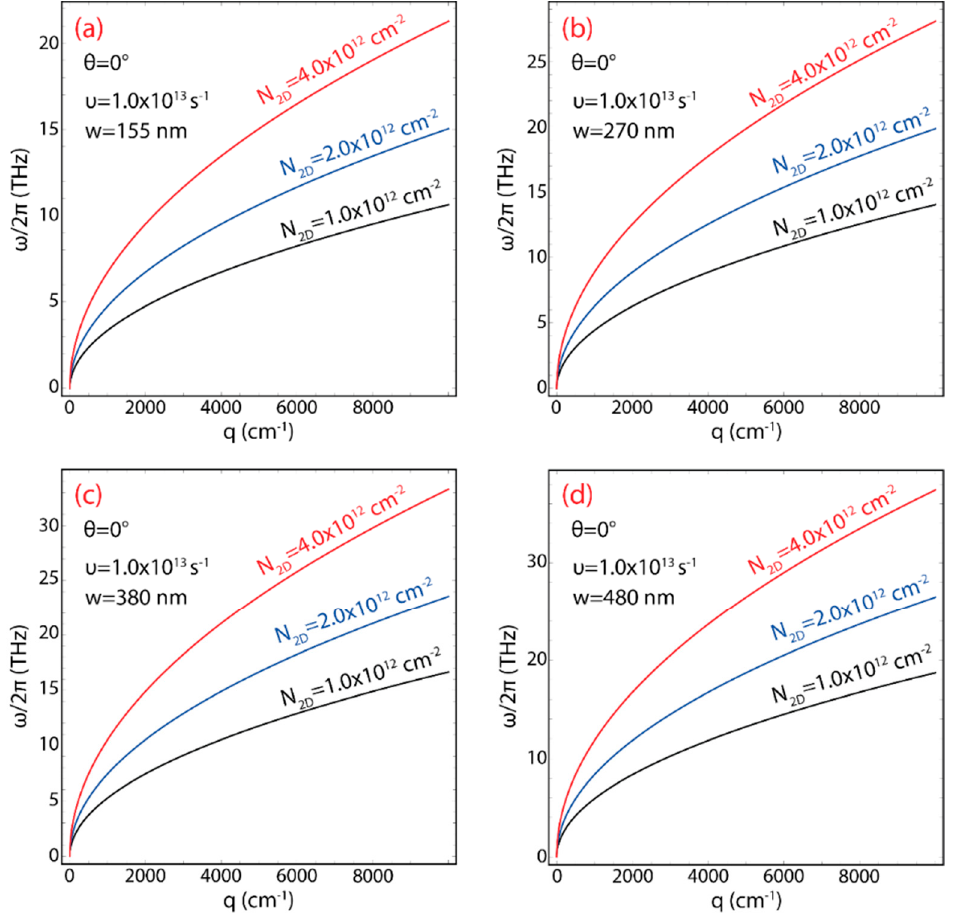
Figure 13. Plasmon frequency dispersion ( ω /2 π ) vs. wave vector ( q ) (using θ = 0, ν = 1.0 × 10 13 s − 1 , and v F = 0.829 × 10 6 m s − 1 ) for different values of charge carrier concentrations ( N 2 D = 1.0 × 10 12 , 2.0 × 10 12 , 4.0 × 10 12 cm − 2 ) with different ribbon widths: ( a ) w = 155 nm, ( b ) w = 270 nm, ( c ) w = 380 nm, and ( d ) w = 480